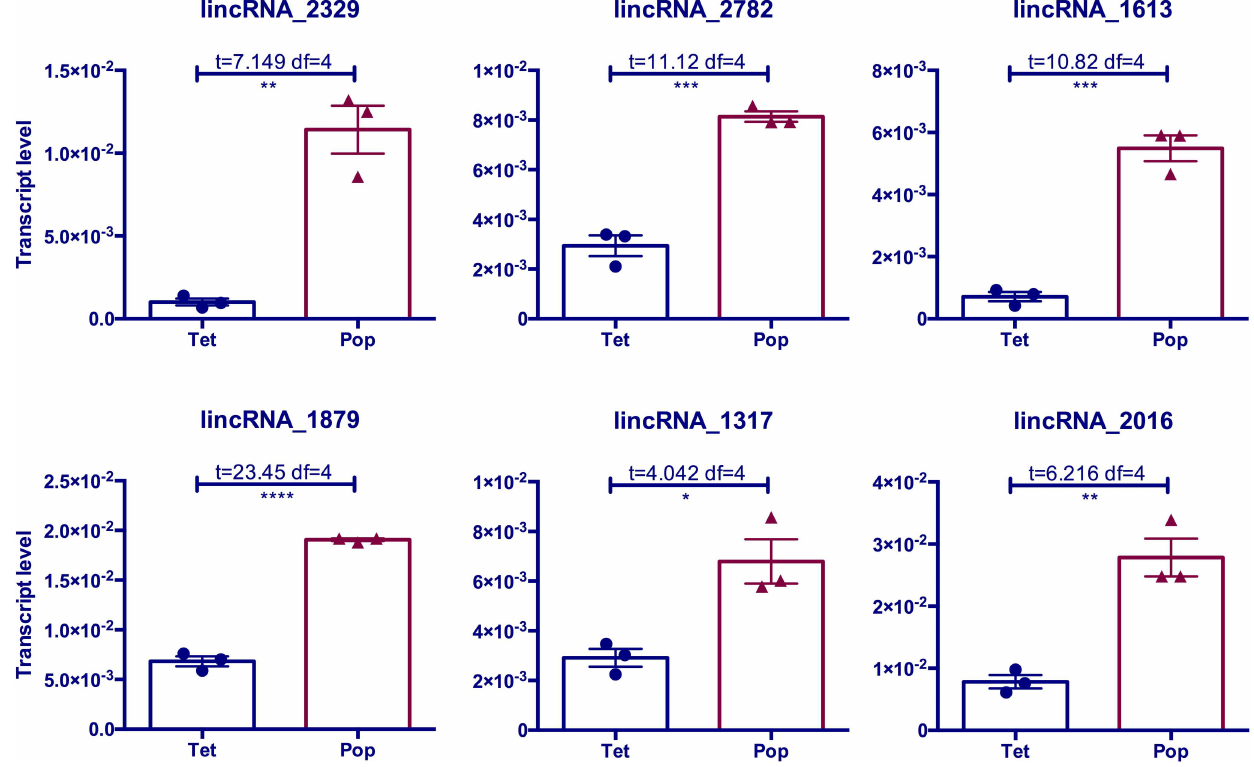
Fig 6. The transcript levels of Ae . aegypti lincRNAs were altered in Wolbachia -infected mosquitoes. RT-qPCR was used to analyze the relative transcript levels of selected numbers of Ae . aegypti lincRNAs in response to Wolbachia infection. For this, RNA from 4-day-old female mosquitoes from w MelPop (Pop)-infected and their tetracycline-cured line (Tet) mosquitoes were used in three biologicalreplicates, each with three technical replicates. * , p < 0.05; ** , p < 0.01; *** , p < 0.001; **** , p < 0.0001.